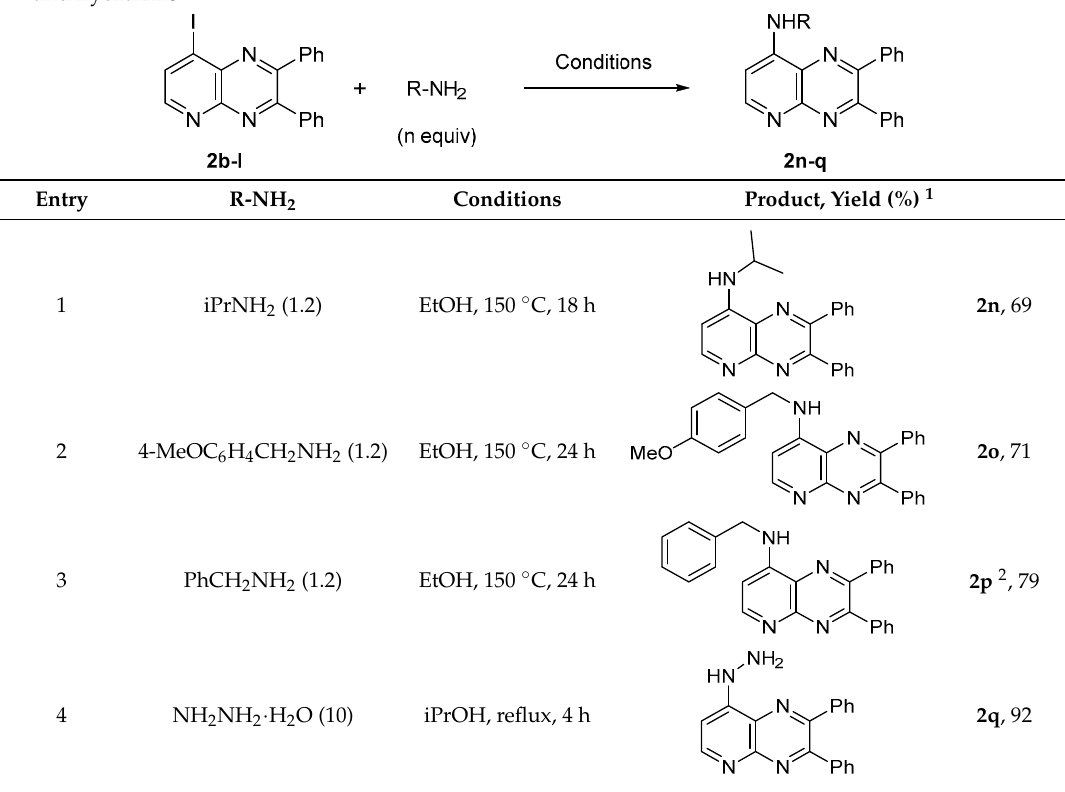
Table 5. Conversion of 8-iodo-2,3-diphenylpyrido[2,3- b ]pyrazine ( 2b-I ) into corresponding amines and hydrazine.